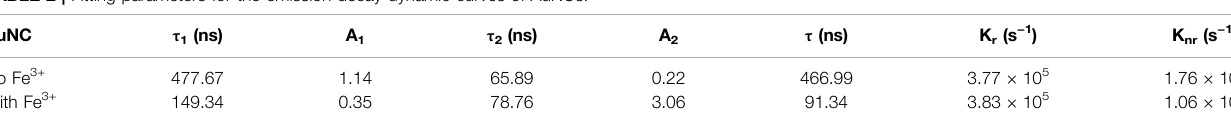
TABLE 2 | Fitting parameters for the emission decay dynamic curves of